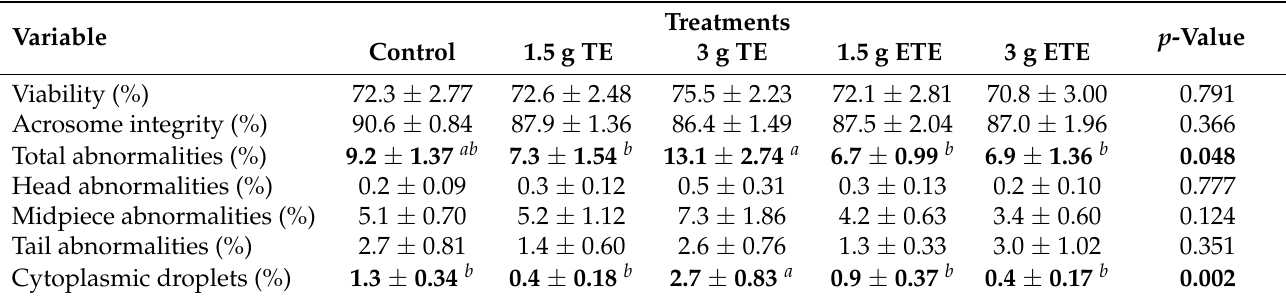
Table 3. The effects of supplementation treatments on sperm viability and morphology (Mean ± SE) of South African Mutton Merino